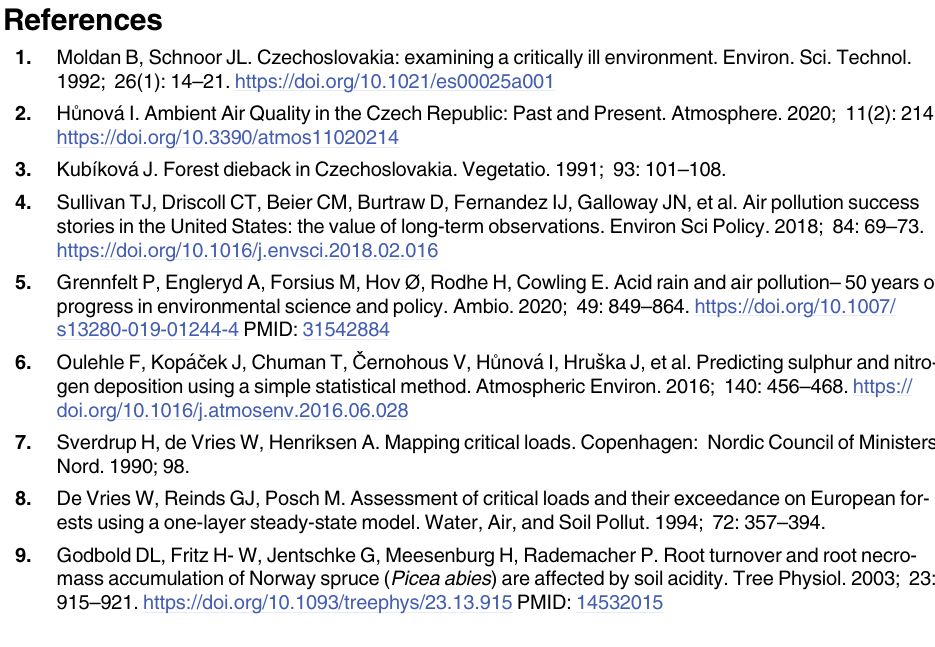
(TIF) S3 Fig. Modelled soil water chemistry at Kova´ ř ska´. (TIF) S4 Fig. Modelled soil water chemistry at Fla´je.